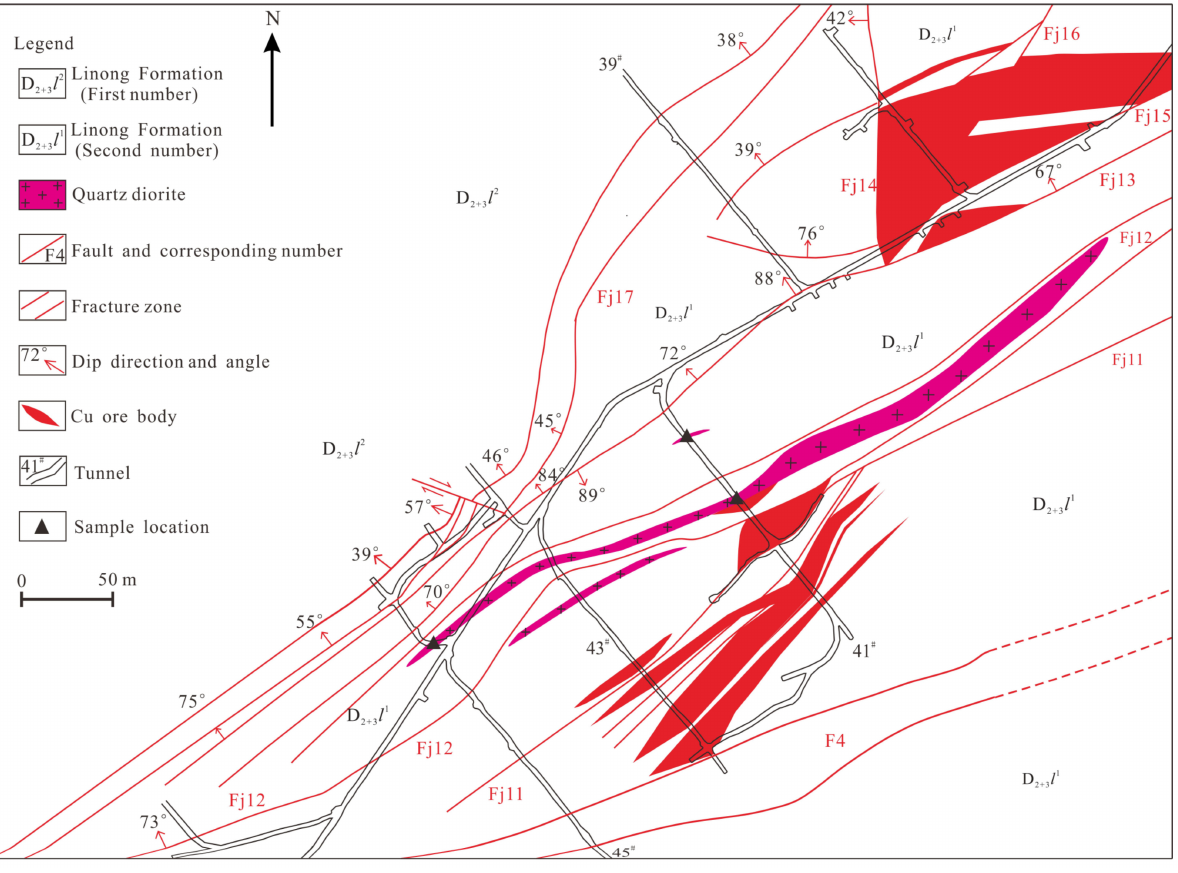
Figure 2. The sketch map of the underground tunnel 3250 m section in the Yangla Cu-W polymetallic deposit